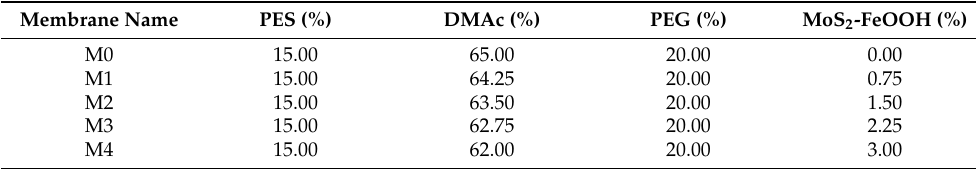
Table 1. Composition of the membrane casting